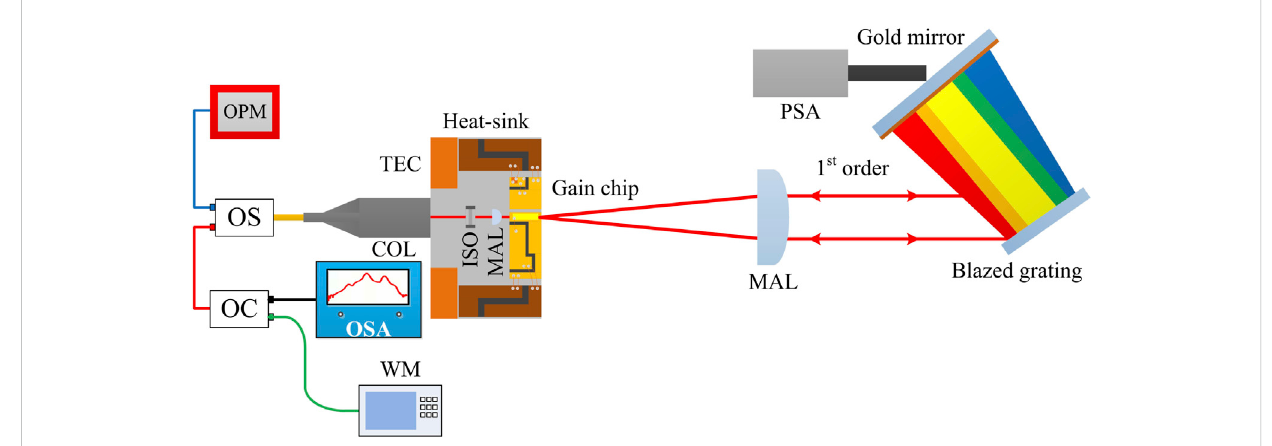
FIGURE 1 Schematicdrawingoftheproposedwavelength-sweptlasersetupbuiltintheLittman-Metcalfcon fi guration.OPM,opticalpowermeter;OS,optical switch;TEC,thermoelectriccooler;MAL, moldedasphericallens;PSA,piezoelectricstack actuator;OC,opticalcoupler;OSA,opticalspectrumanalyzer; WM: wavelength meter; COL, collimator; ISO,